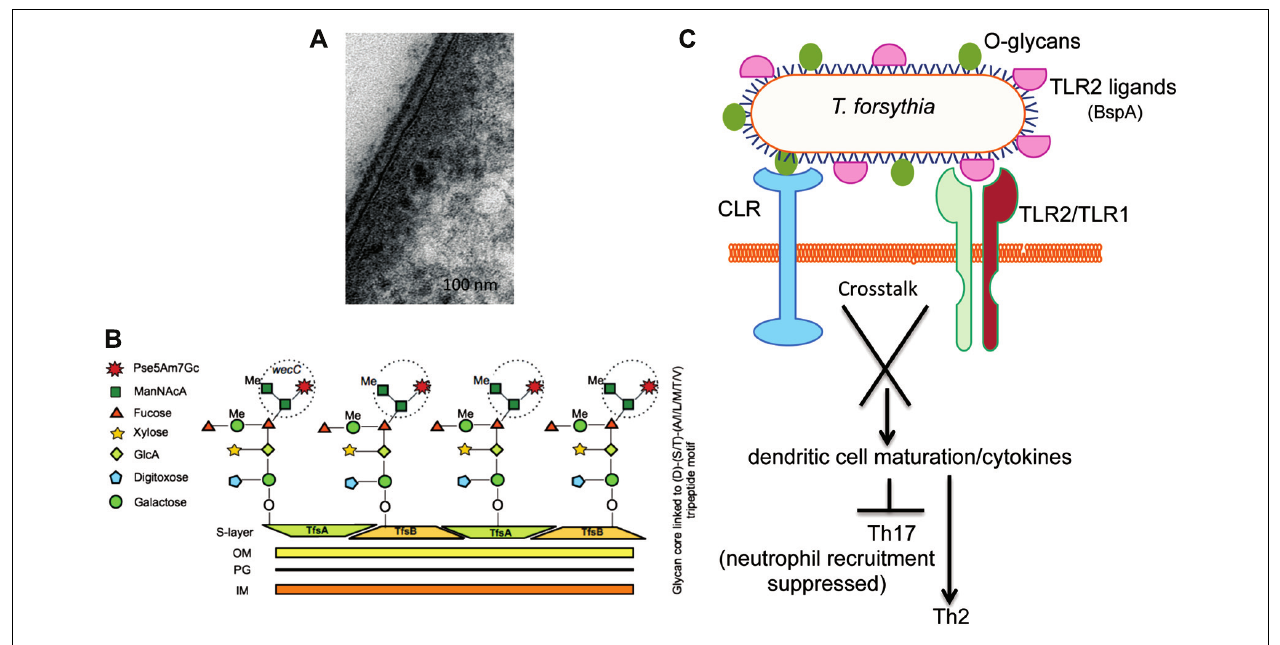
the wecC operon is circled. (C) Signaling crosstalk between a C-type lectin-like receptor (CLR) and TLR2 activated by O -glycans and TLR2 ligands (e.g., BspA), respectively, may orchestrate T helper cell